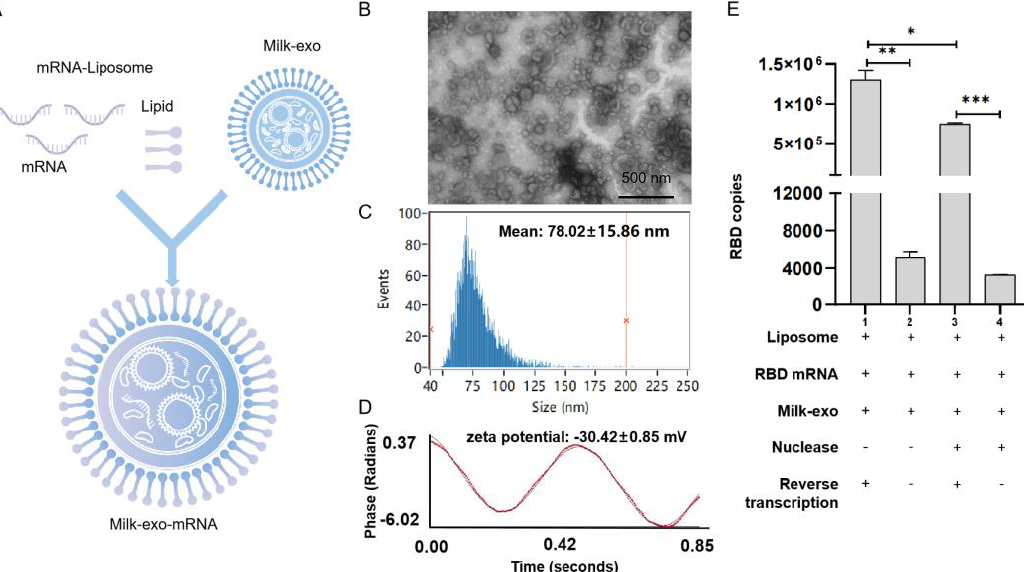
Figure 4. Characterization of milk − derived exosome − based vaccine for SARS−CoV−2 . ( A ) Flowchart of vaccine preparation for SARS−CoV−2. The morphology ( B ), particle size distribution ( C ), zeta potential ( D ), and RBD mRNA loading efficiency ( E ) were determined. Scale bars = 500 nm.